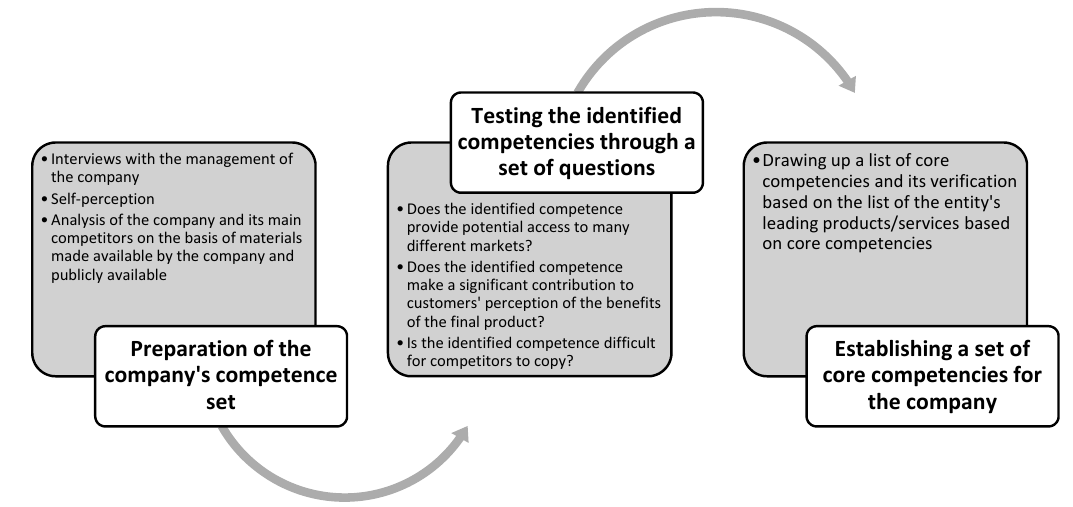
Figure 3. Procedure for identifying the company’s core competencies.